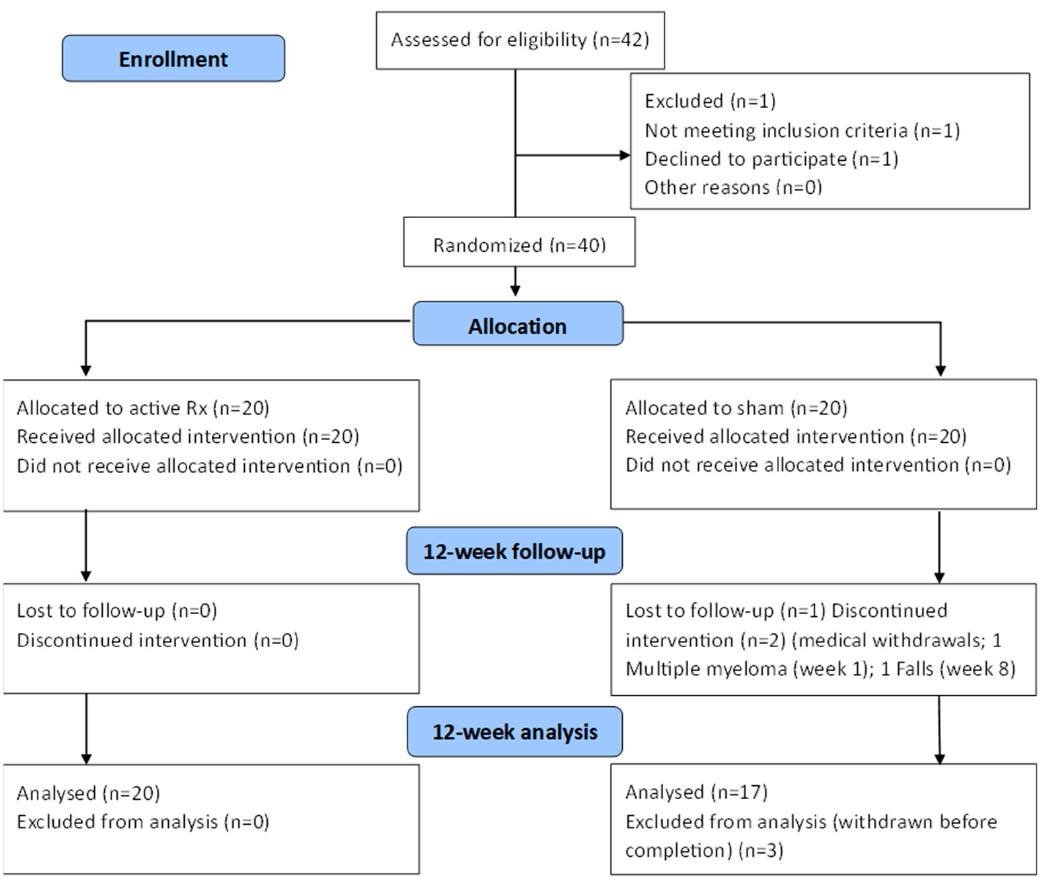
Figure 1. Consort Flow Diagram. Withdrawals: falls week 8, multiple myeloma week 1.